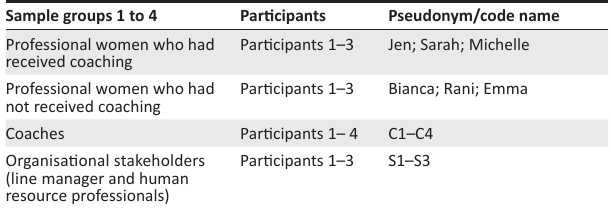
TABLE 2: Sample groups with pseudonyms and code